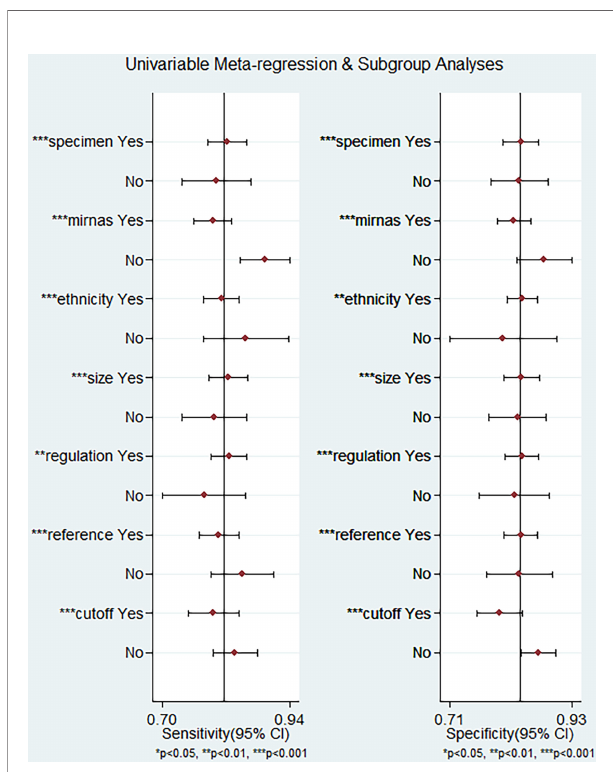
FIGURE 7 | Meta-regression analysis for examining sensitivity and speci fi city of miRNAs for the diagnosis of diabetic retinopathy.